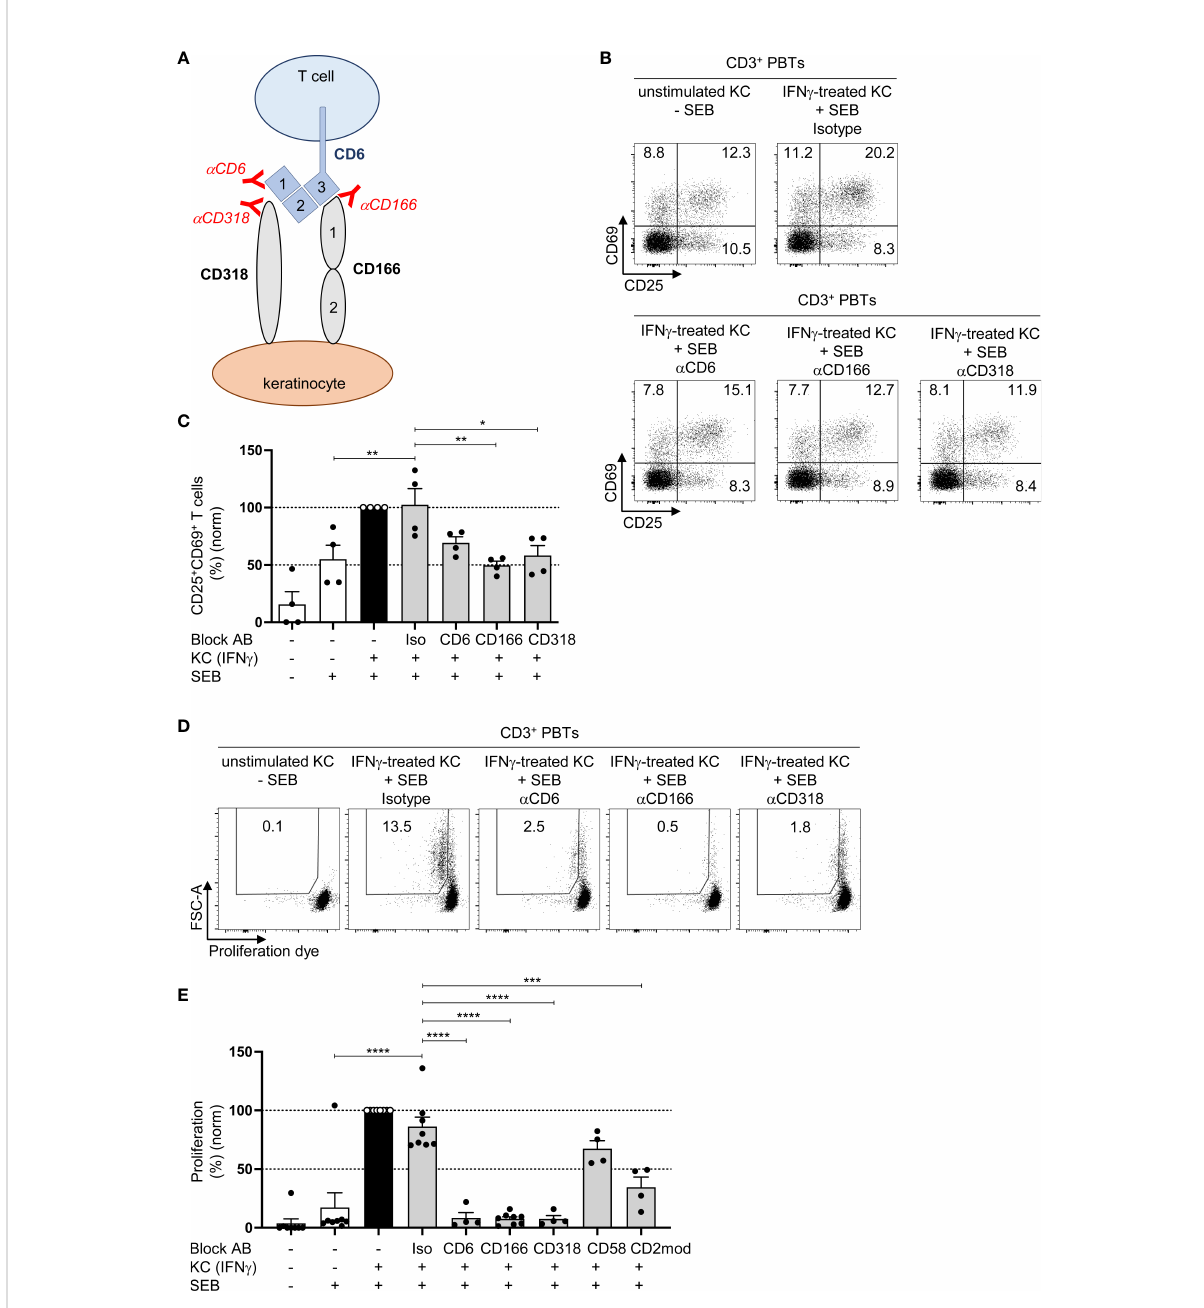
FIGURE 3 CD166/CD318-induced costimulatory signals transmitted by CD6 are required for keratinocyte-dependent T cell activation and proliferation. (A) Graphical scheme of the putative interaction between KCs and T cells and the binding sites of the used blocking antibodies against CD6, CD166 and CD318. a CD6 binds to domain 1 (d1) of CD6, a CD166 binds to domain 1 (d1) of CD166, while a CD318 binds to CD318 which blocks the interaction between CD6 and CD318. (B, C) CD3 + PBTs were cultured with untreated KCs (white bars) or IFN g -pretreated KCs (black and grey bars), loaded with SEB (+) and then analyzed for expression of the T cell activation markers CD25 and CD69 (after 24 h) by fl ow cytometry. (B) Representative dot plots and (C) statistical evaluation of the effect of isotype control antibodies (iso), or blocking antibodies against CD6, CD166, or CD318 on the CD25 and CD69 expression (n = 4 individual T cell donors). (D, E) Effect of isotype control antibodies (iso), or blocking antibodies against CD6, CD166, or CD318 on T cell proliferation after 72 h coculture. Proliferation was assessed by CFDA dilution assay. (D) Representative dot plot and (E) statistical evaluation (n ≥ 3 individual T cell donors). Data was normalized to PBTs cultured with IFN g - pretreated KCs loaded with SEB (black bar). Data is represented as mean ± SEM. ****=p<0.0001; ***=p 0.001; **=p<0.01;